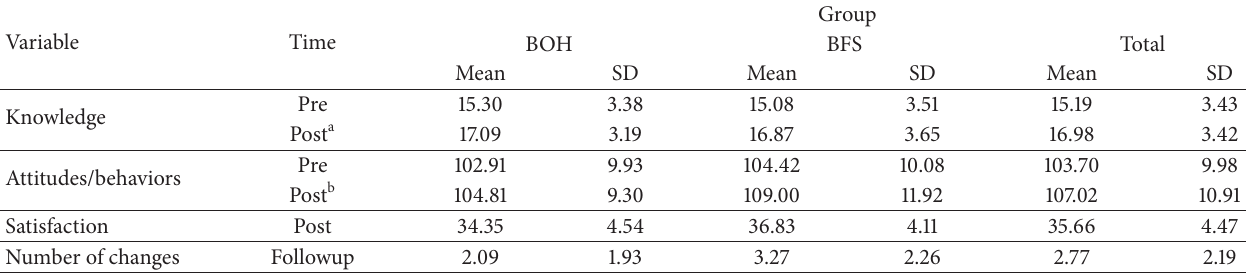
Table 7: Means and standard deviations for study